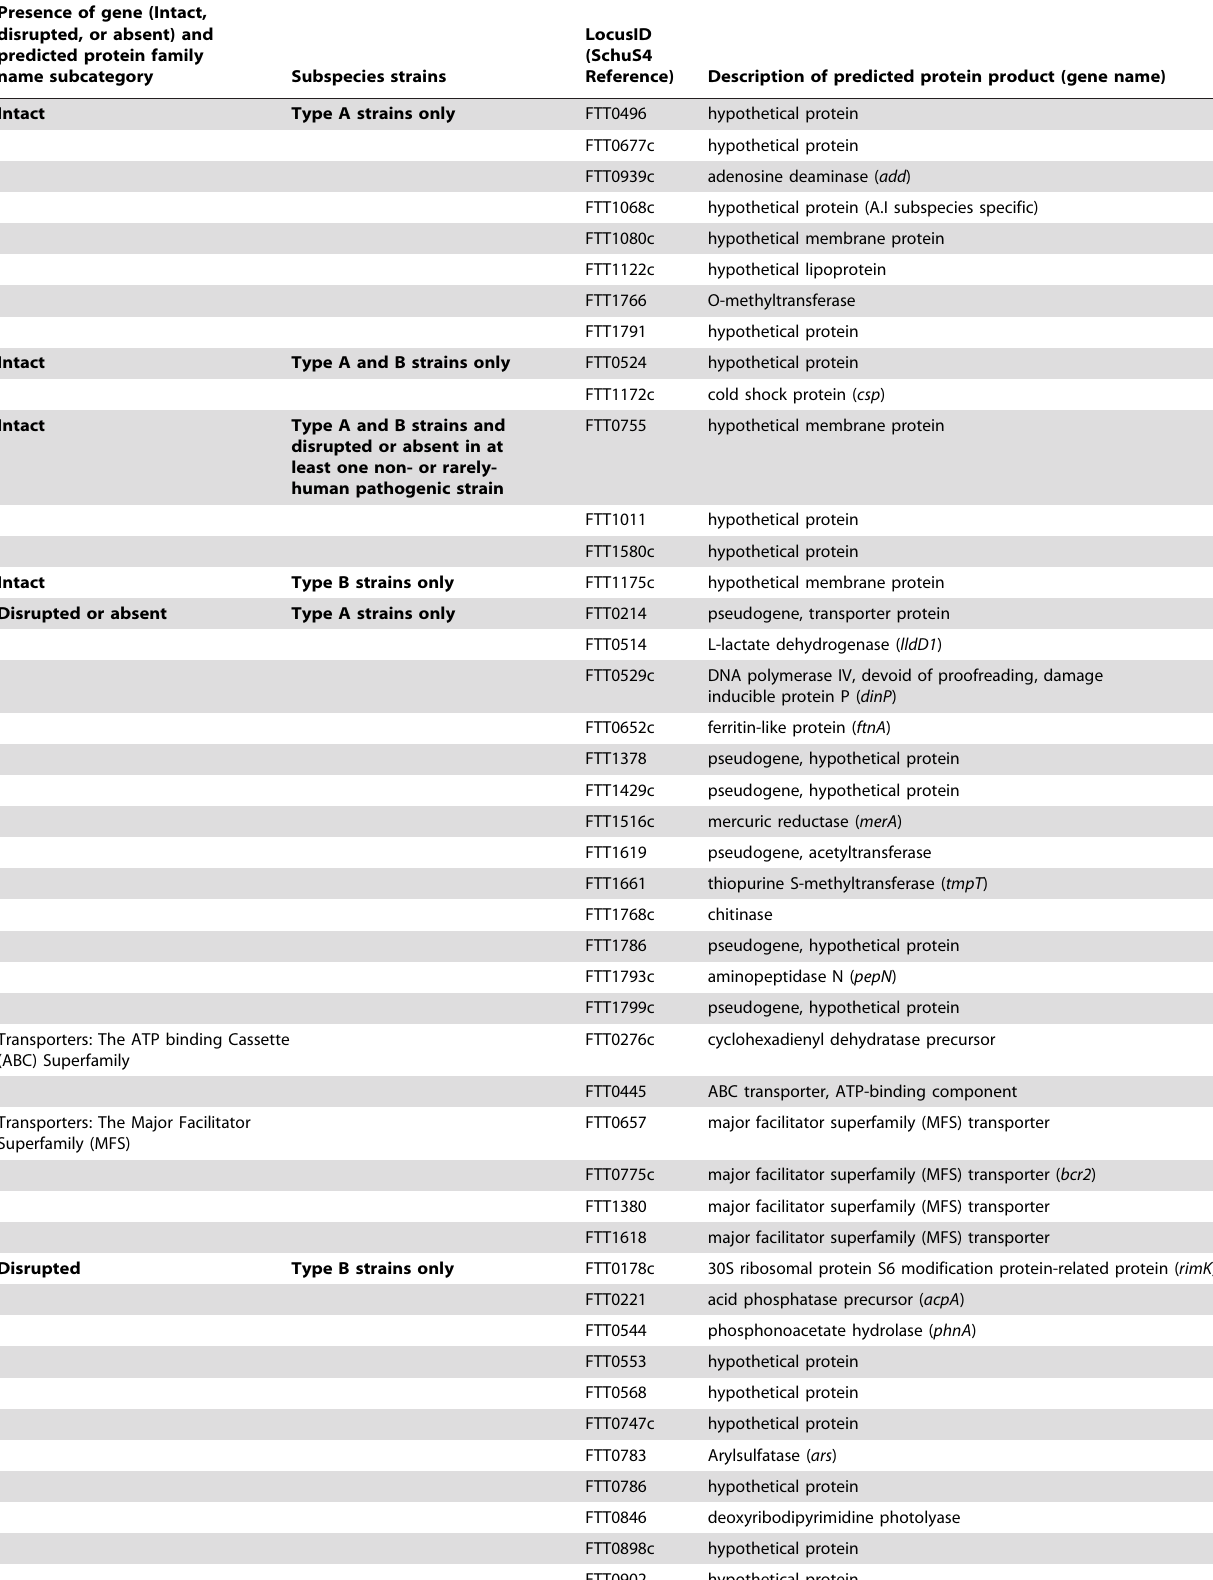
Presence of gene (Intact, disrupted, or absent)